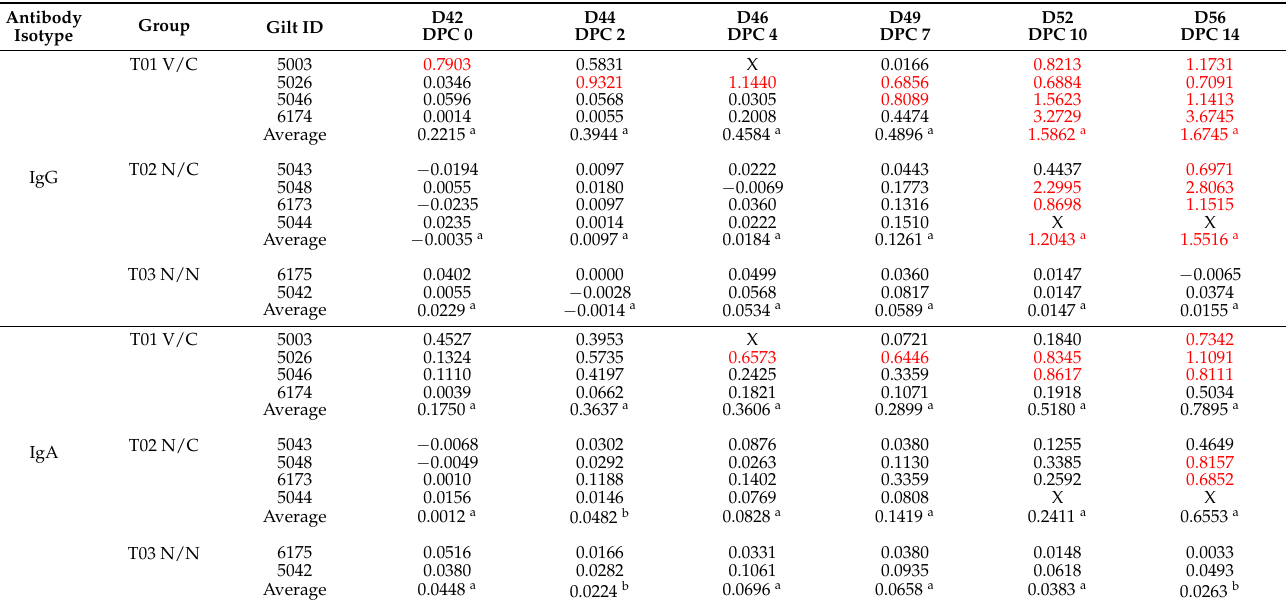
Table 3. Gilt anti-PEDV IgG and IgA response in colostrum/milk as tested by PEDV whole virus- based ELISA (S/P ratios shown in the table).